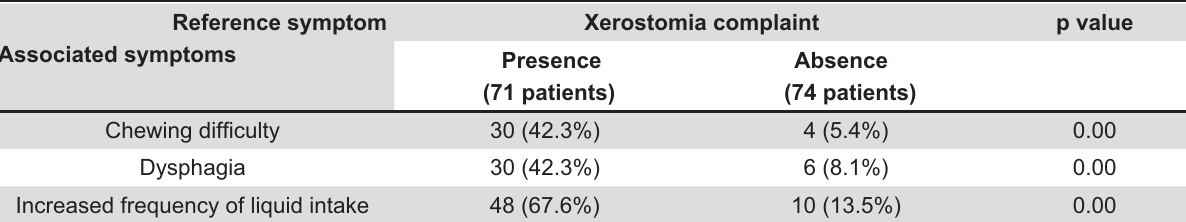
foods? of liquid intake? Figure 1- Anamnesis focused on hyposalivation Table 1- (cid:4)(cid:30)(cid:14)(cid:12)(cid:23)(cid:16)(cid:17)(cid:11)(cid:15)(cid:4)(cid:29)(cid:14)(cid:16)+(cid:14)(cid:14)(cid:15)(cid:4) ((cid:14)(cid:19)(cid:11)(cid:18)(cid:16)(cid:11)W(cid:17)(cid:23)(cid:4)(cid:9)(cid:11)W)(cid:12)(cid:23)(cid:17)(cid:15)(cid:16)(cid:4) (cid:23)(cid:15)*(cid:4) (cid:9)(cid:10)(cid:14)+(cid:17)(cid:15);(cid:4)*(cid:17)(cid:13)(cid:22)(cid:9)(cid:28)(cid:12)(cid:16)(cid:20)(cid:7)(cid:4)*(cid:20)(cid:18))(cid:10)(cid:23);(cid:17)(cid:23)(cid:4) (cid:23)(cid:15)*(cid:4) (cid:17)(cid:15)(cid:9)(cid:19)(cid:14)(cid:23)(cid:18)(cid:14)*(cid:4) (cid:13)(cid:19)(cid:14)X(cid:28)(cid:14)(cid:15)(cid:9)(cid:20)(cid:4) (cid:11)(cid:13)(cid:4)(cid:12)(cid:17)X(cid:28)(cid:17)*(cid:4)